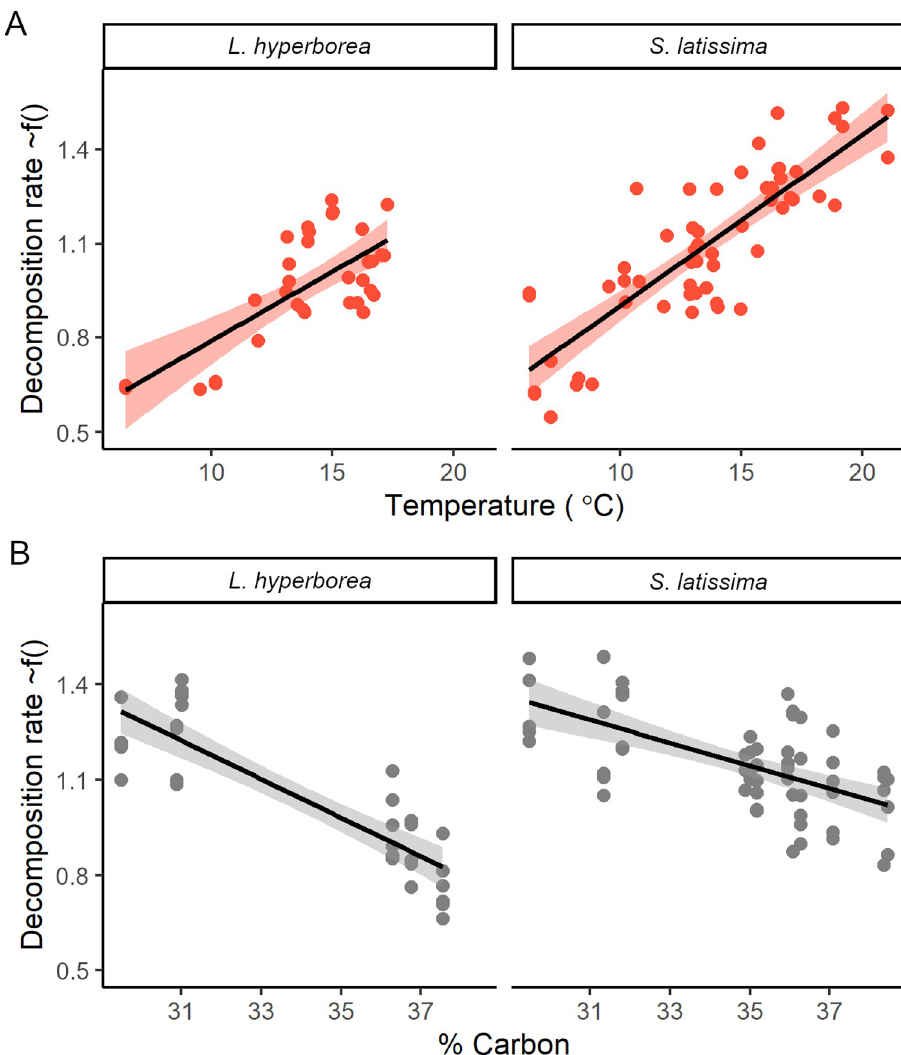
Fig 3. Relationships between decomposition rate and water temperature, carbon content, and species. Relationships between kelp decomposition rate (% d − 1 ) and significant predictor variables in generalized linear models: (A) average water temperature during the experiment and (B) initial % carbon content for both species, from the generalized linear mixed effect models, with all other variables in the model held fixed (Data C in S1 Data). Black lines are the expected value from the model, shaded error bar (a and c) is confidence interval, and points are partial residuals for each sampling time at each site. Plots are created with R package visreg [44].